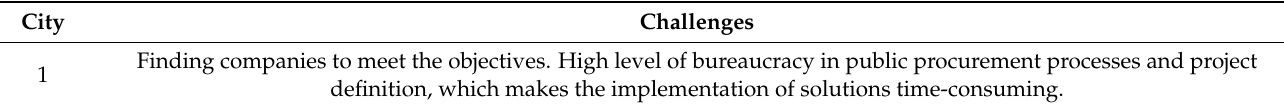
Table 4. Challenges of smart city